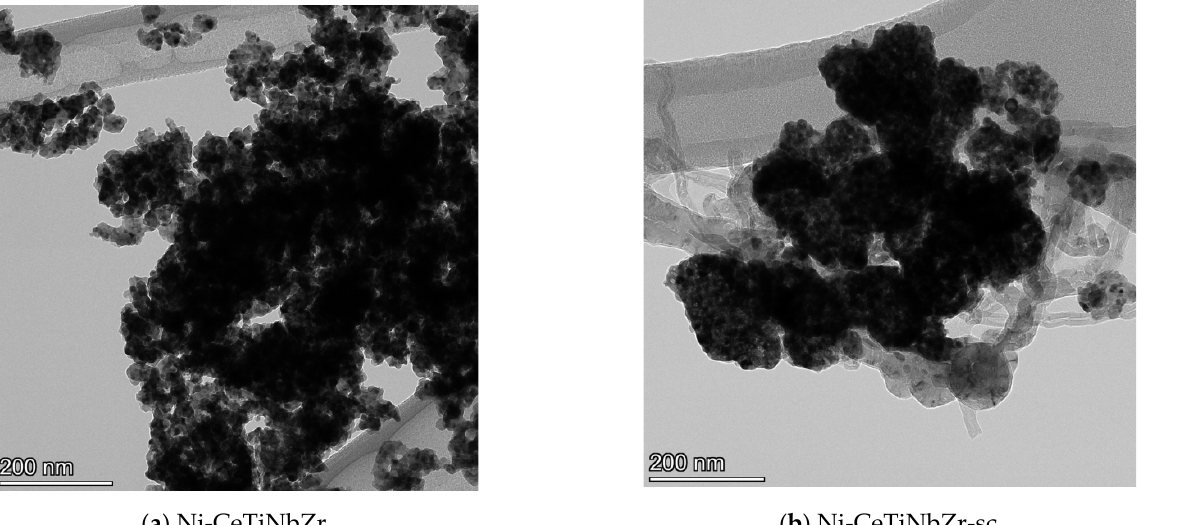
Figure 7. TEM images of Ni-CeTiNbZr catalysts prepared by citrate method ( a ) and by supercritical synthesis ( b ) after testing in methane dry reforming.